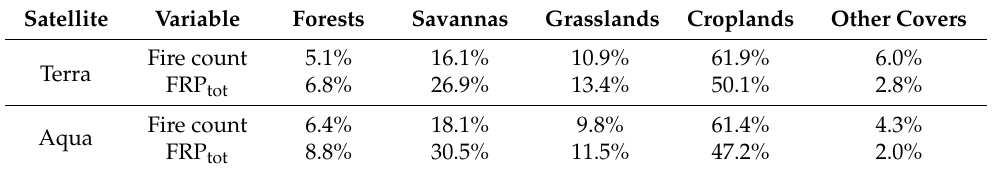
Table 2. Percentages of multi-annual average fire counts and total fire radiative power (FRP tot ) detected by Terra and Aqua satellites among different land covers in the NEC region. Satellite Variable